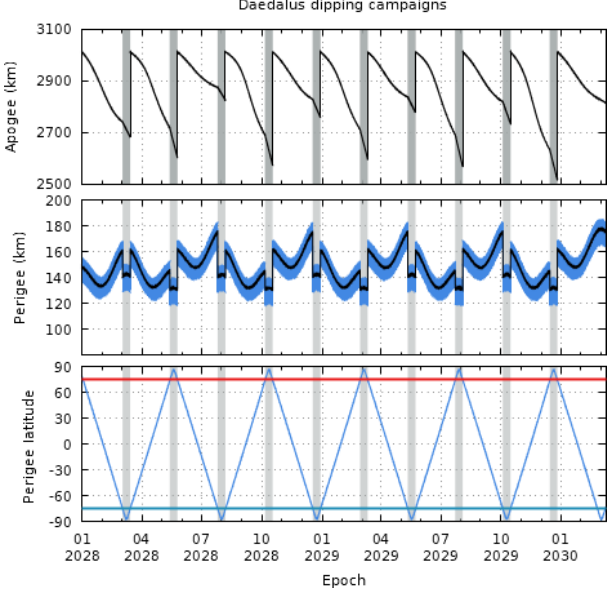
Figure 10. Daedalus apogee, perigee and perigee latitude. The times and duration of perigee descents are shown as gray-shaded